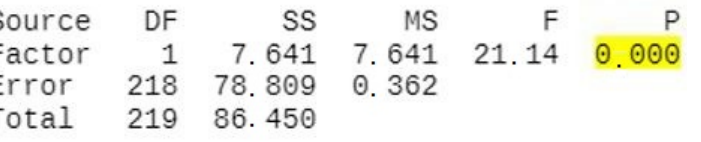
Figure 9. One-way ANOVA-A2 and B2 show that results are significantly different p < 0.05.